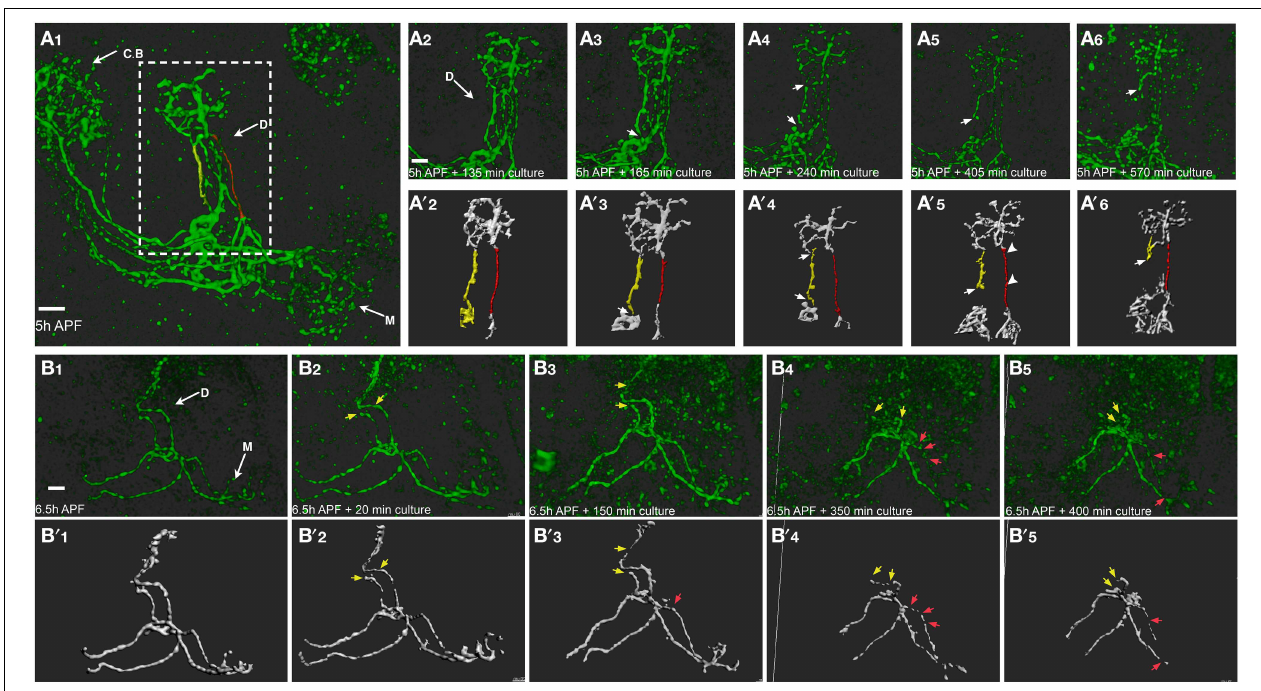
FIGURE 6 | Time lapse imaging in a single cell resolution allows a careful examination of the cellular mechanisms of remodeling. Two-photon Z-stacks of selected images extracted from a time-lapse movie of multi-cell clone (A) or two-cell clone (B) labeled by mCD8-GFP driven by Gal4-GMR82G02. (A) Different axons within the same bundle undergo fragmentation in different kinetics. While the lateral axon (marked in yellow) is already fragmented (arrows in A 3 ), the more medial axon (marked in red) only